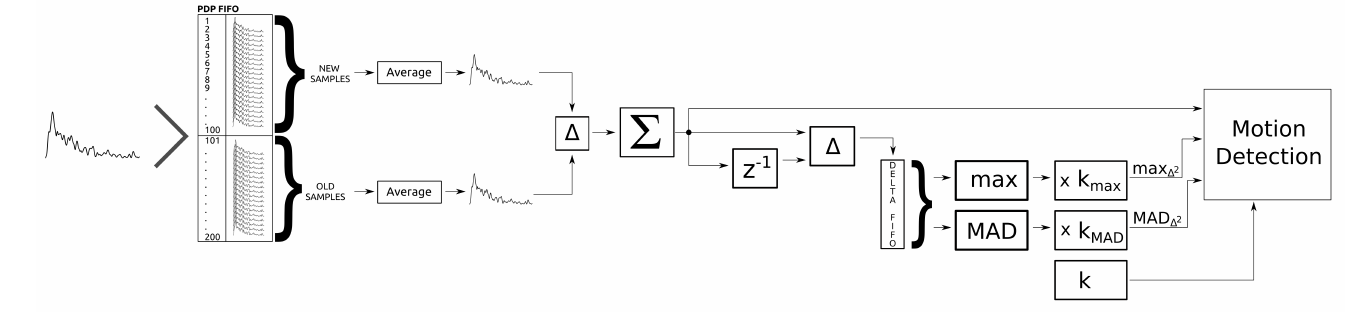
Figure 10. Online adaptive motion detection algorithm flowchart.